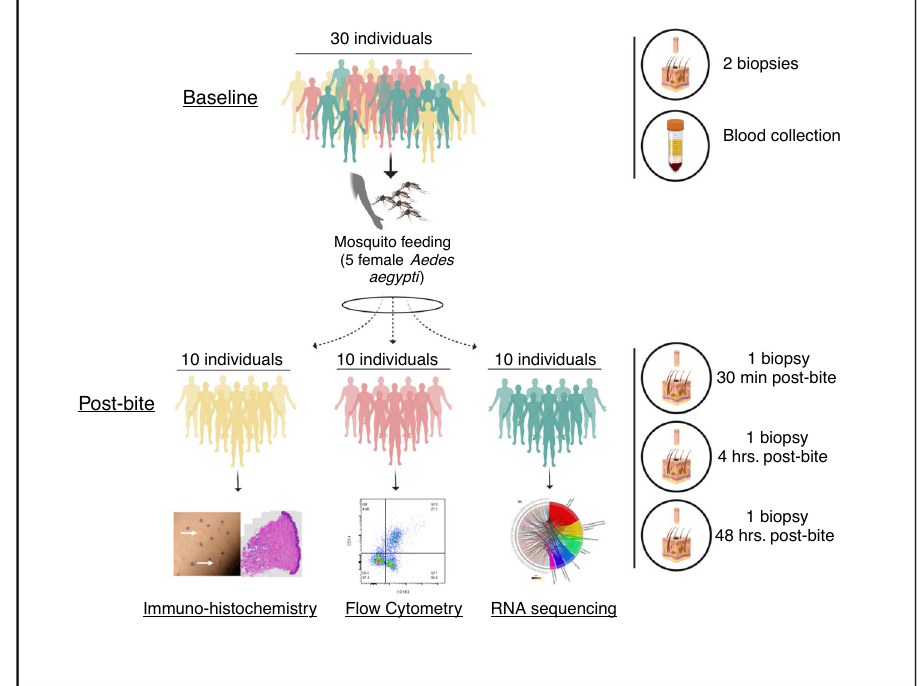
Fig. 1 | Graphicalrepresentationofstudy design. Thirty Cambodianparticipants wereenrolledinthestudy.Eachpatientunderwentamosquitofeeding( fi vefemale Aedes aegypti ) for 10min. Each volunteer underwent a 3-mm biopsy from a mos- quito bite site at30min, 4h, and 48h. Distinct bite siteswerebiopsied atdifferent